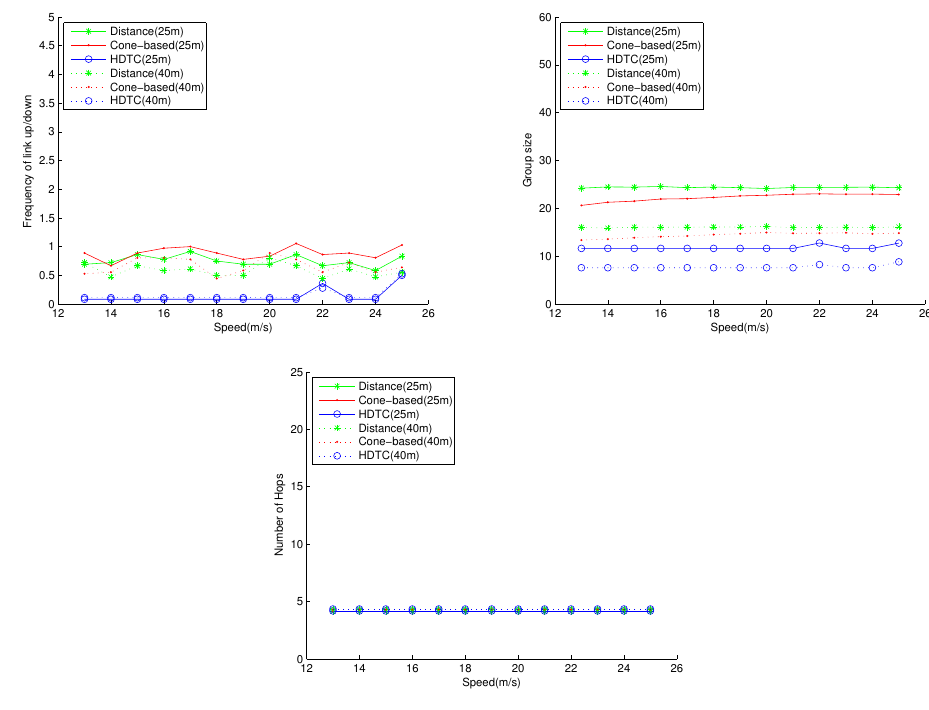
Figure 16. Scenario 2: The connection time, the frequency of the link up/down, the group size and the number of hops with varying the lane headway.